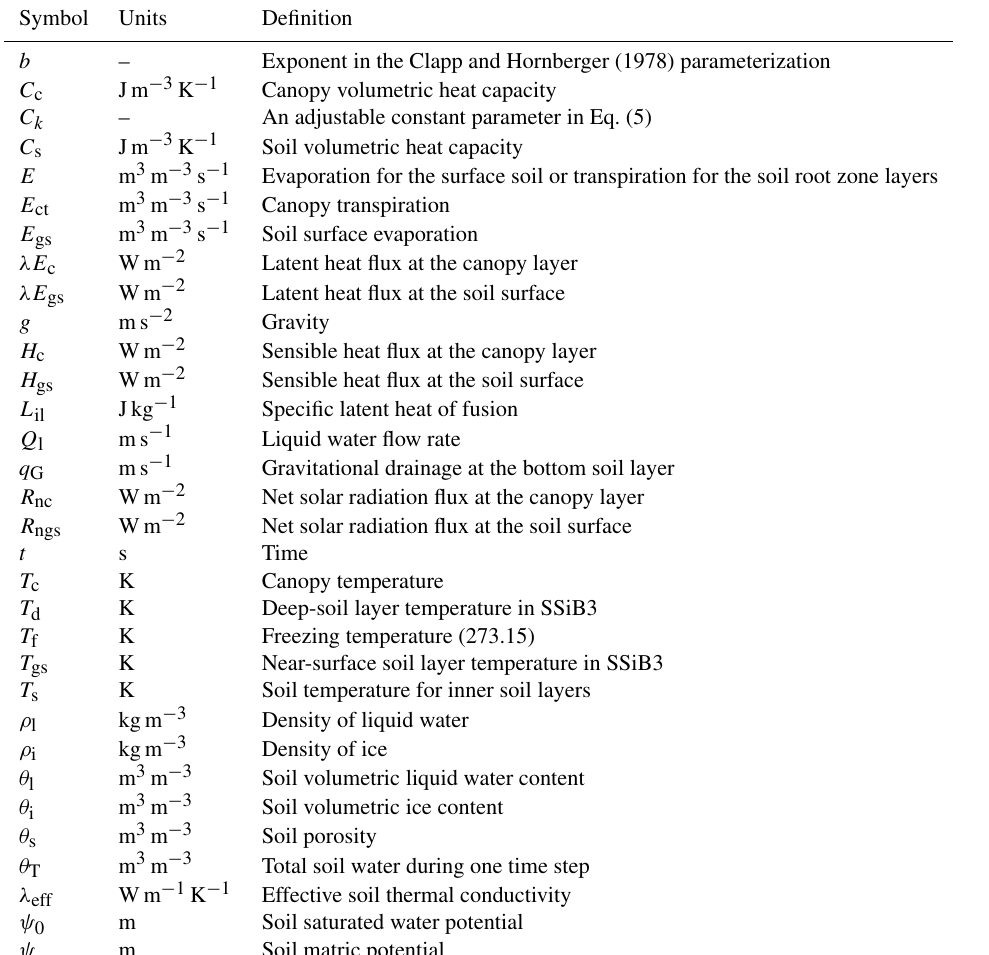
Table A1. List of symbols with units and